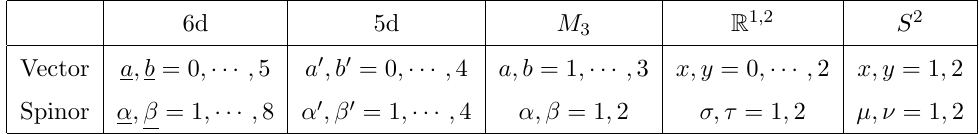
Table 2 . Space-time indices.